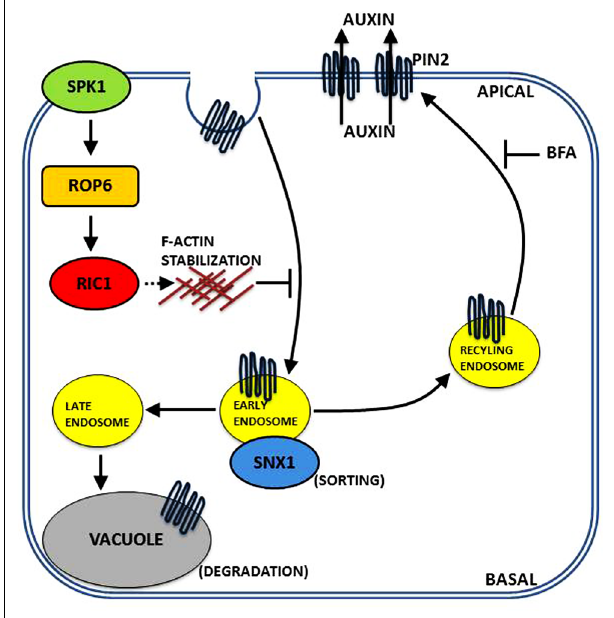
FIGURE 3 |A model in roots for PIN2 polar distribution via a ROP signaling mechanism. Data indicate that the auxin-mediated inhibition of polar PIN2 internalization is regulated by the SPK1–ROP6–RIC1 pathway. Auxin is proposed to activate the SPK1–ROP6–RIC1 pathway and inhibit PIN2 internalization.The localized inhibition of PIN2 internalization via ROP6 signaling causes PIN2 to be retained in the PM, which generates a positive feedback mechanism for maintaining polar PIN2 distribution to the